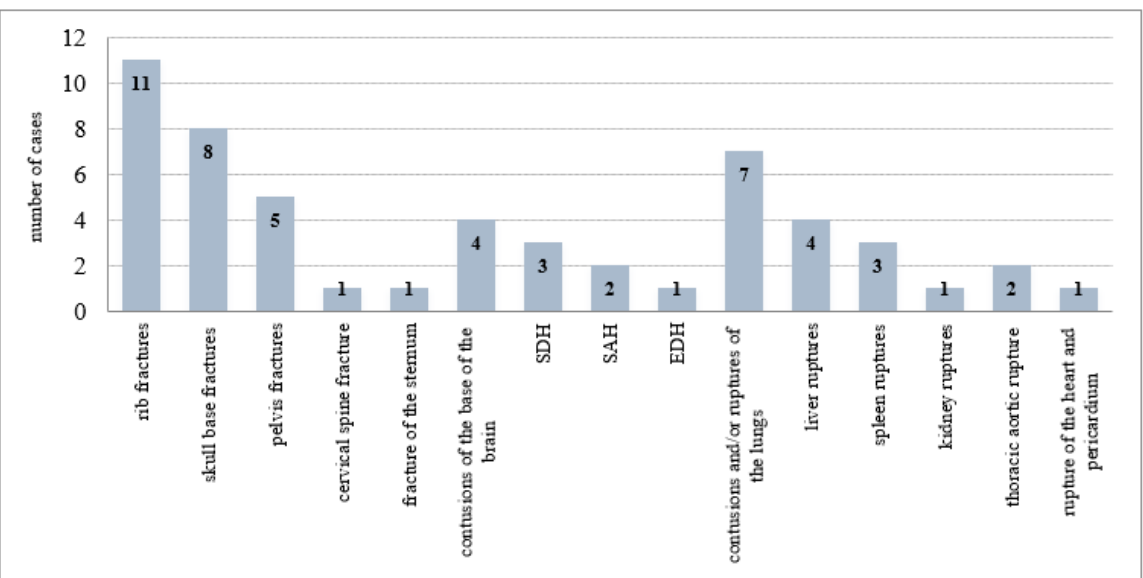
Figure 4. The false negative cases after repeated assessment of CT scans (65) for each type of injury. SDH—subdural hemorrhage; SAH—subarachnoid hemorrhage; EDH—epidural